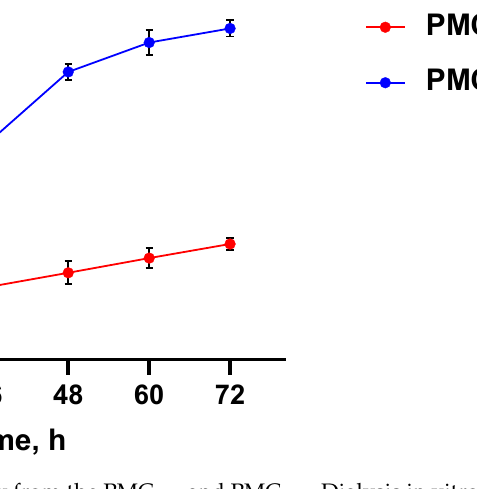
Figure 3. The DOX release efficiency from the PMC 500 and PMC 300 . Dialysis in vitro.